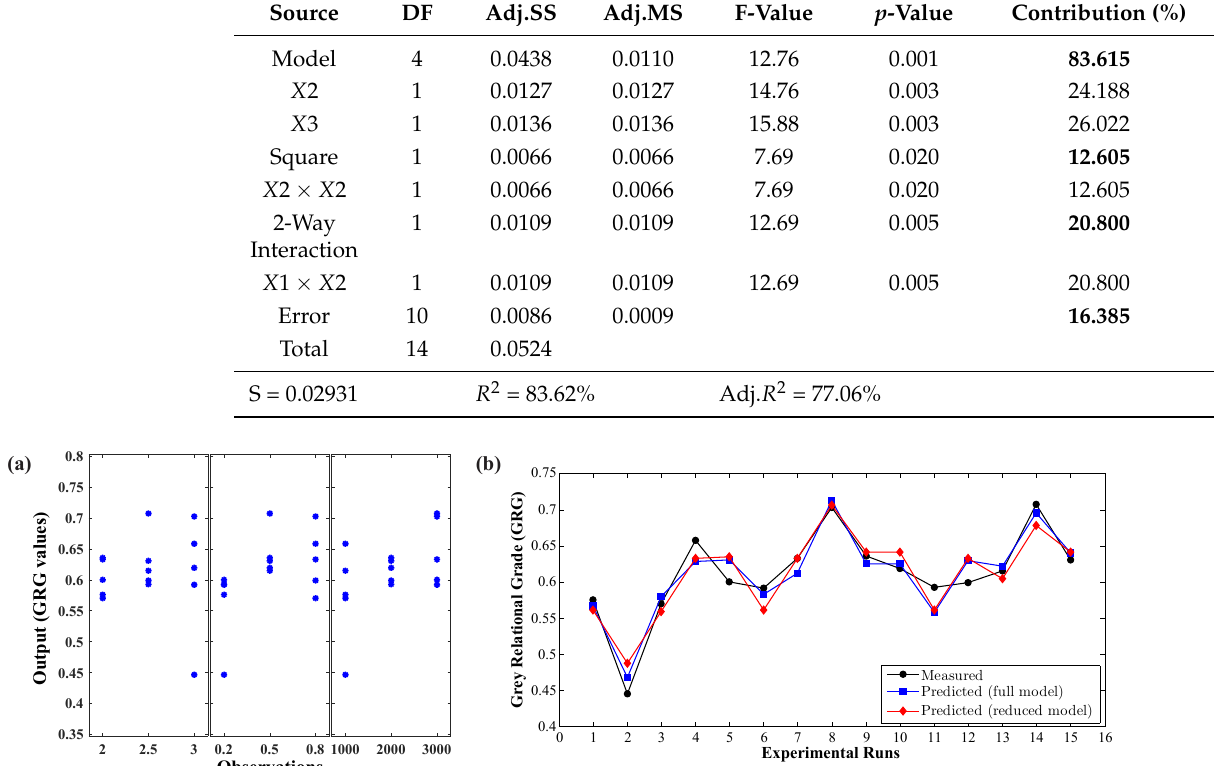
Figure 12. ( a ) Scatter plot of observed data; ( b ) measured vs. predicted data of GRG